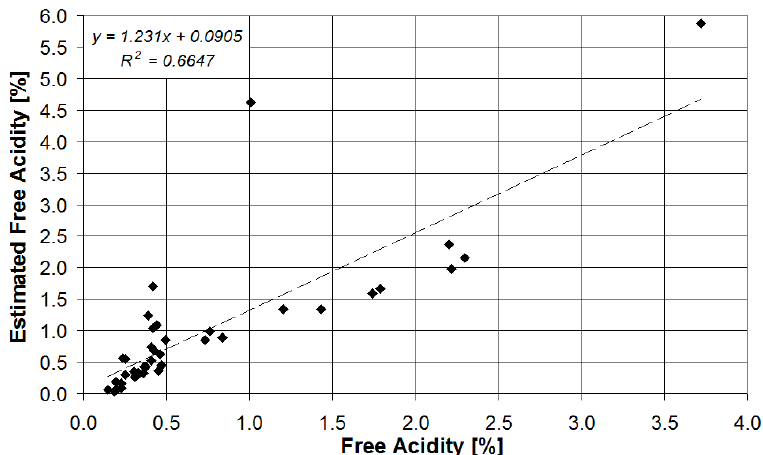
Figure 11. Estimated value of free acidity without any compensation algorithm (i.e., using Equation (9)) plotted vs. the free acidity determined with the reference procedure.